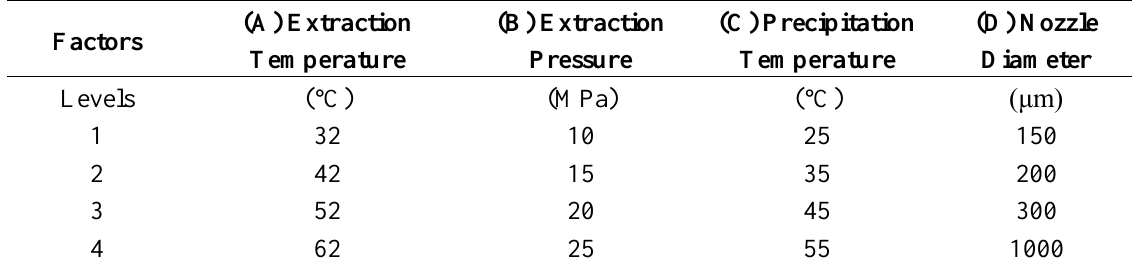
Table 4. The factors and levels of the orthogonal array